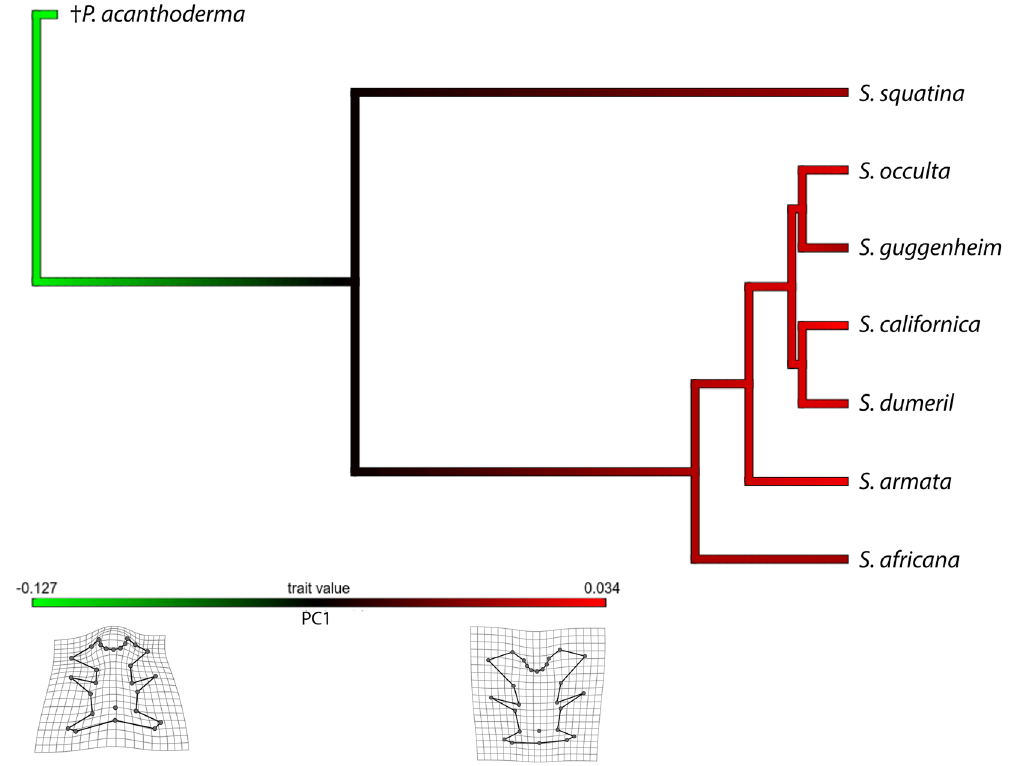
Figure 4. Phylogeny of the Squatiniformes analysed and evolution of the neurocranium. The colours of the branches indicate the shape variation with green towards the shape on the minimum values of the PC1 and in red the maximum values of PC1.